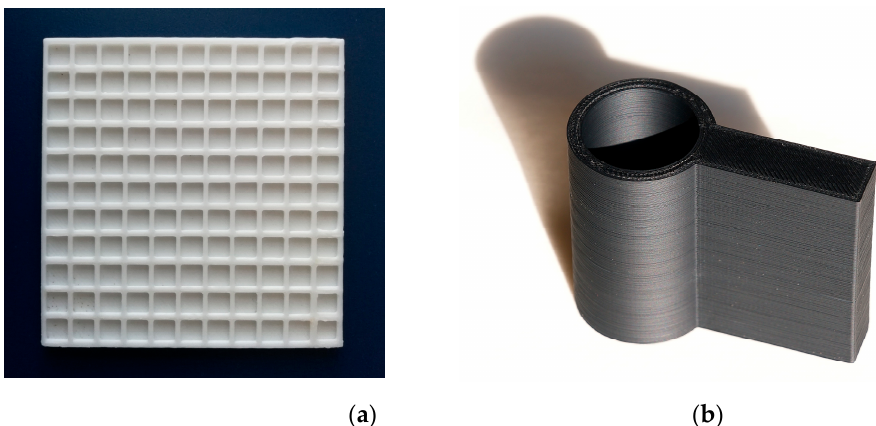
Figure 1. Photographs of a measuring pad ( a ) and smartphone camera holder ( b ) manufactured from acrylonitrile butadiene styrene (ABS) polymer.